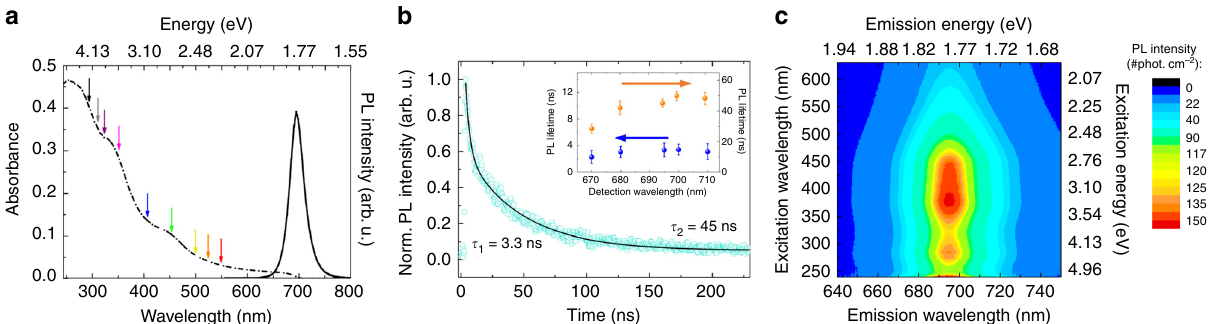
Fig. 2 Optical characterization. a Absorbance (dotted) and PL (solid) spectra. The colored arrows indicate the photon energies used in the transient absorption experiment. b Time-resolved photoluminescence (PL) measurement for λ det = 695nm which was fi tted using a bi-exponential function and yielding decay times τ 1 = 3.3 ns and τ 2 = 45 ns. The inset shows the obtained lifetimes for all detection wavelengths. The PL lifetimes with corresponding amplitudes are shown in the inset. The uncertainty is determined by the statistical error from the fi tting method. c 2D contour plot of the PL excitation, showing the effect of excitation energy on the PL emission and intensity. A PL maximum is observed around <250 nm (>4.96 eV), which could be the fi rst sign of carrier multiplication. The excitation and emission intensities are corrected for the wavelength dependent components of the setup and spectral